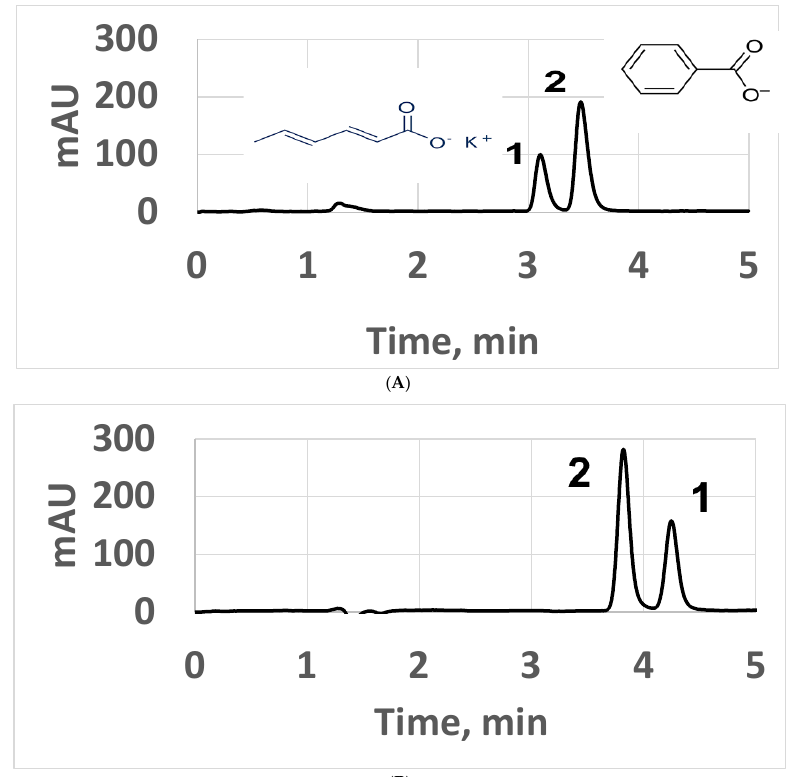
Figure 8. Chromatograms of benzoic acid and sorbitol standards (1 mM). The ( A ) 85% DMC - 15% 10 mM buffer/ethanol and the ( B ) 85% MeCN - 15% 100 mM buffer/ethanol. Peak 1: Sorbate, and peak 2: Benzoate. Wavelength: 215 nm.